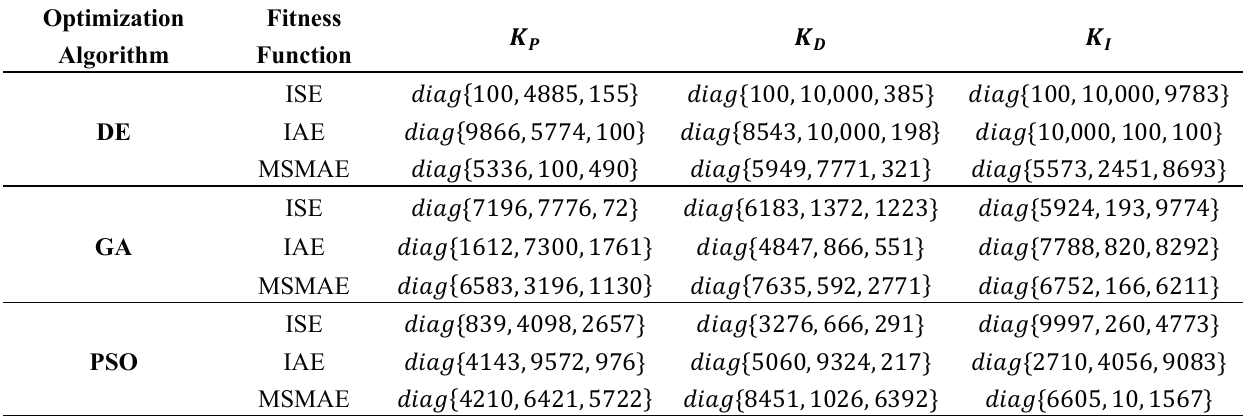
Table 6. Resulting gains for linear